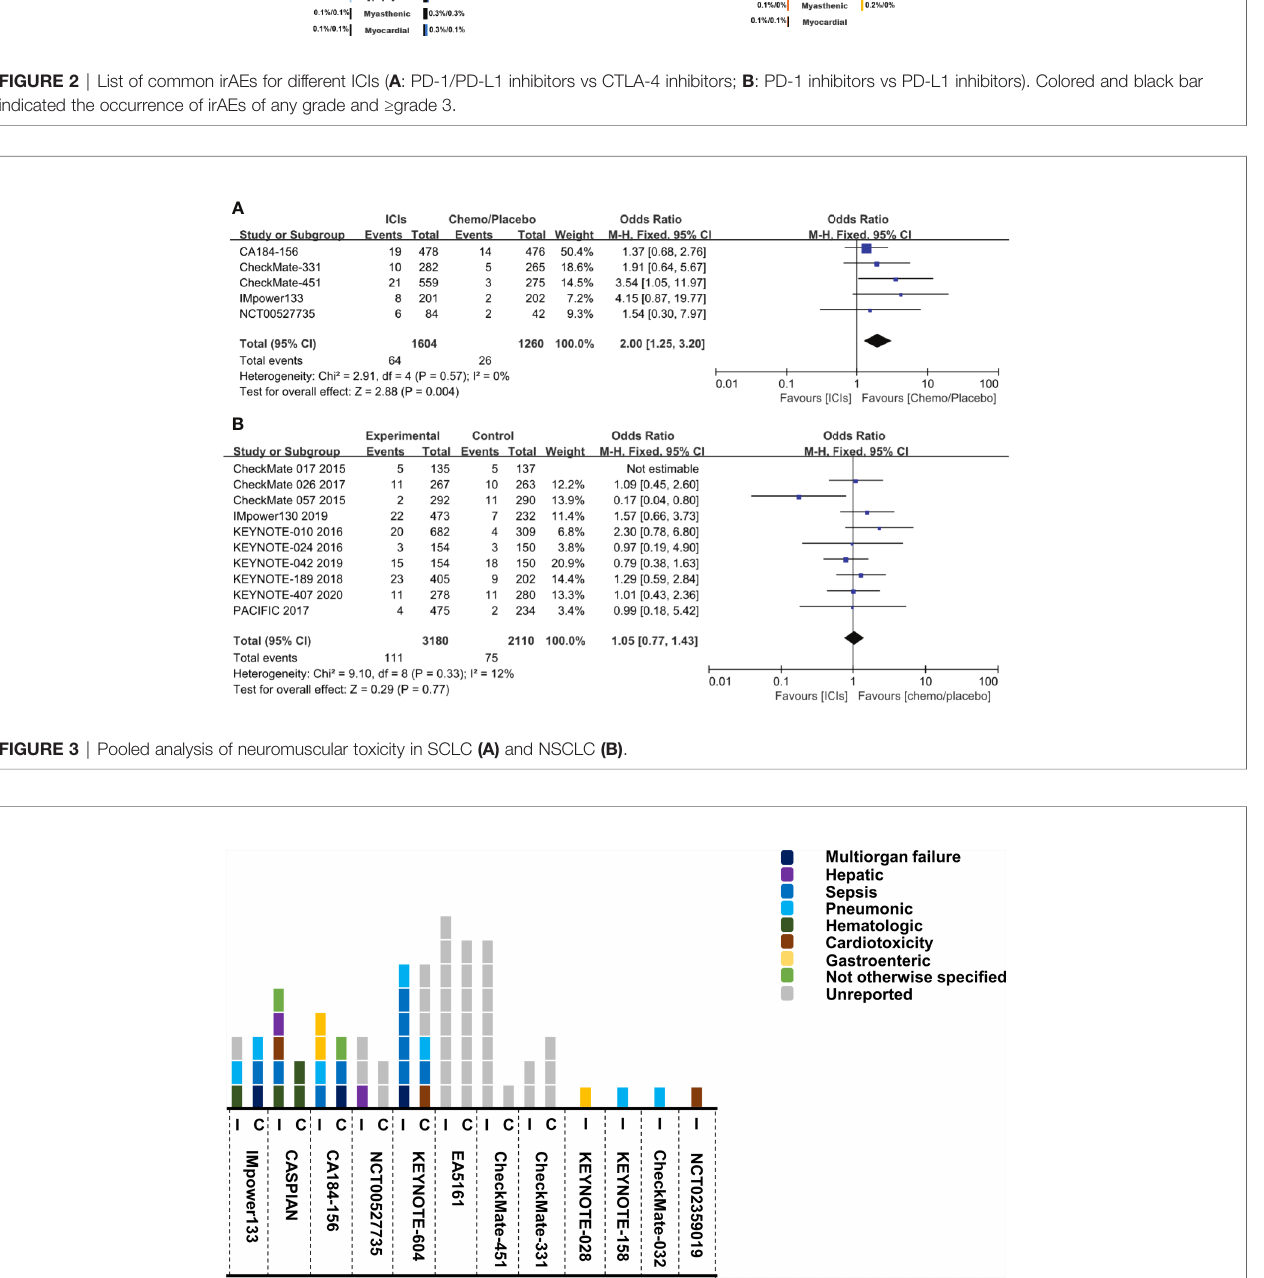
FIGURE 4 | Summary of death events in SCLC trials. Each square represented one event, and different color stood for the causes of death. I, ICIs group; C, chemo/placebo